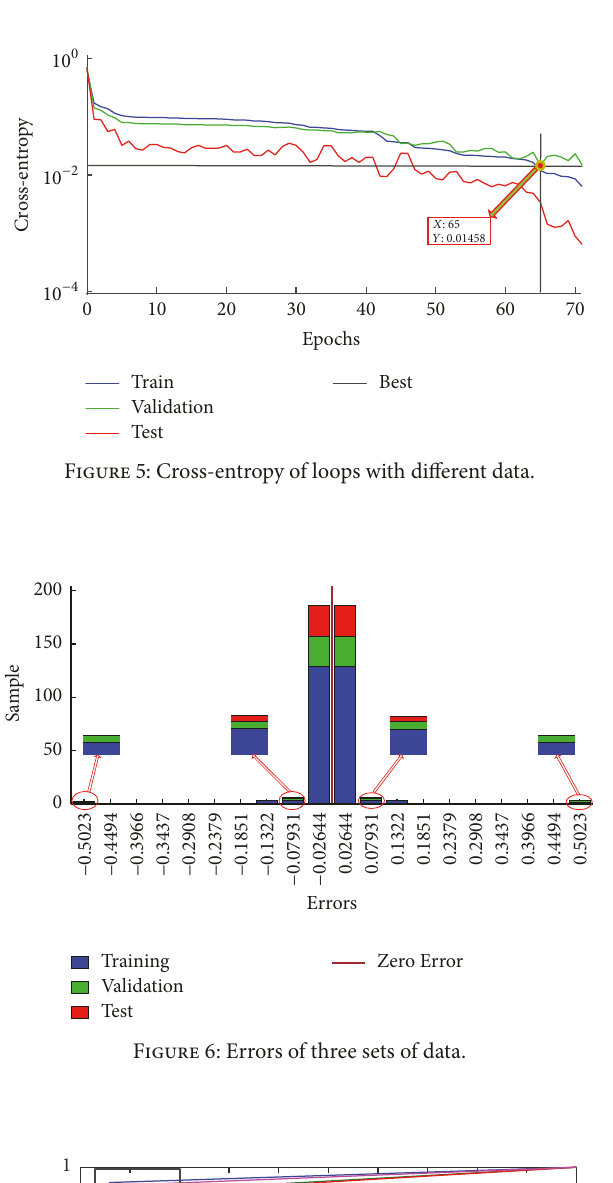
Figure 9: Classification performances of different methods. Table 3: Classification results for different